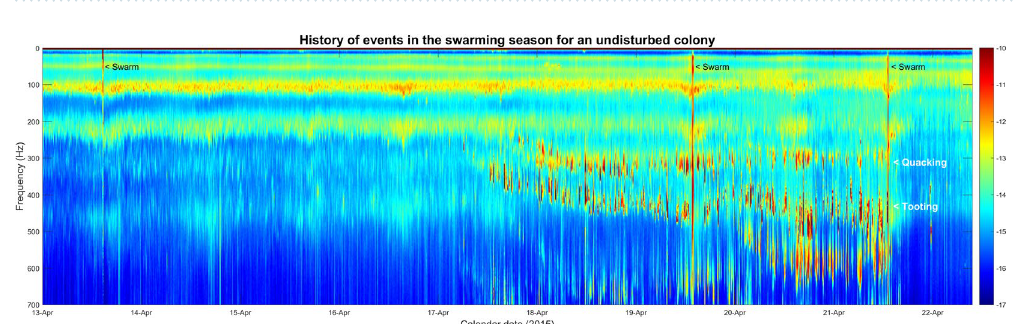
Figure 11. Spectrogram image of 3-minute averaged spectra extracted from the 2015 French colony 22 dataset, representing the occurrences of queen piping recorded within a colony with an original queen that was left unclipped and was left undisturbed throughout its swarming activities between 13 th and 22 nd April 2015. Midnight of each day begins at each date label on the horizontal axis. Pixel intensity represents logarithmic spectral amplitude from low (blue) to high (red) in arbitrary units. This figure was created using the MATLAB (R2018b) software